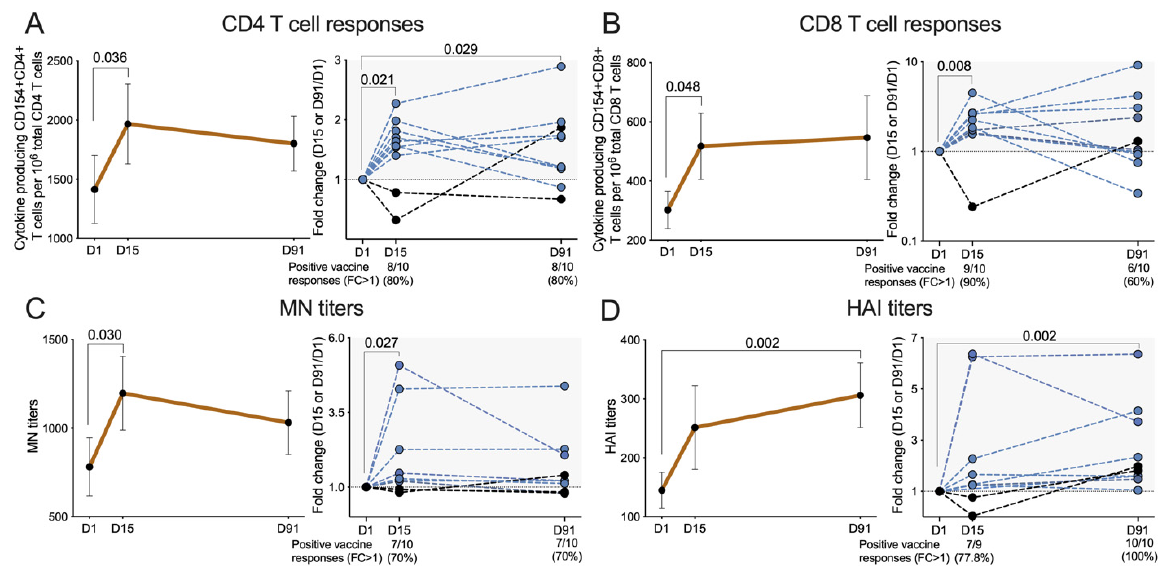
Figure 1. Cellular and humoral immune responses before and after vaccination. Cellular and humoral immune responses were measured at baseline (D1, pre-immunization), D15 (14 days post vaccination), and D91 (90 days post vaccination). ( A , B ) CD4 and CD8 T cell responses were represented by number of influenza virus reactive cytokine producing CD154+ CD4 or CD8 T cells per million of total CD4 or CD8 T cells. Left panels show the general trends of changes in CD4 and CD8 T cell responses for each visit ( n = 10). Right panels show the vaccine induced changes for each individual person as represented by fold of change (FC) in CD4 or CD8 responses at D15 and D91 compared to baseline at D1 (FC = D15 or D91/D1). Percentages of positive vaccine responders (defined by FC > 1) at D15 and D91 were illustrated below the plots. ( C , D ) Humoral immune responses were measured by both microneutralization (MN) assay and hemagglutination inhibition (HAI) assay, and total responses of all 4 strains represented. Left panels show the general trends of changes in MN or HAI antibody titers for each visit ( n = 10). Right panels show the vaccine induced changes for each individual person as represented by fold of change (FC) in antibody titers at D15 and D91 compared to baseline at D1 (FC = D15 or D91/D1). Percentages of positive vaccine responders (defined by FC > 1) at D15 and D91 were illustrated below the plots. ( A – D ) Normality of data distribution was accessed by Shapiro–Wilks test. Parametric data at D15 or D91 were compared to baseline (D1) by paired Student’s t test (two-tailed). Non-parametric data at D15 or D91 were compared to baseline (D1) by Wilcoxon test (two-tailed). Data were plotted as median with interquartile range for non-parametric data and mean with SEM for parametric data. p values < 0.05 were considered statistically significant.